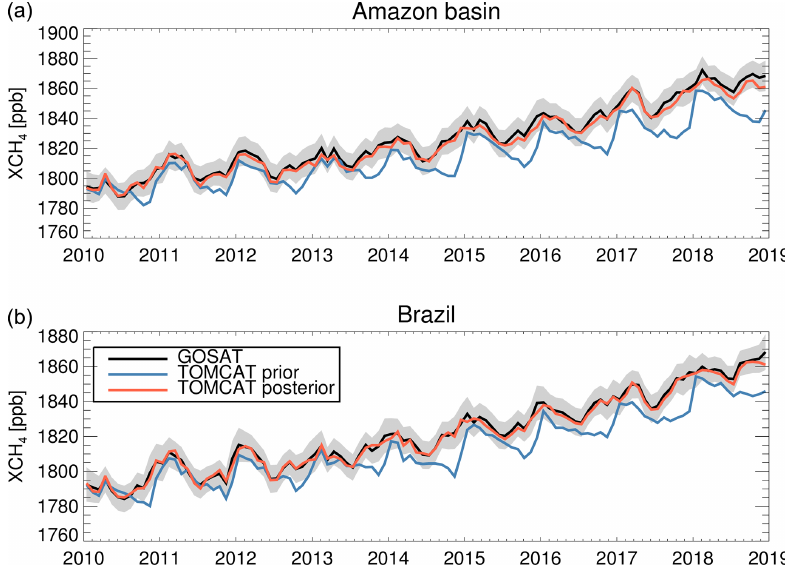
Figure A3. Error-weighted monthly mean GOSAT XCH 4 (black lines) over the Amazon basin (a) and Brazil (b) . Also shown are the simulated mean prior (blue) and posterior (red) XCH 4 values with GOSAT averaging kernels applied. Grey shading shows the monthly mean observation uncertainty within each region. It should be noted here that since simulations for each year were initiated using values from the previous year’s posterior mean output for both the prior and the posterior initial atmospheric concentrations, the gradient of the blue line is artificially higher than it would be for a free-running simulation using the prior emissions only.